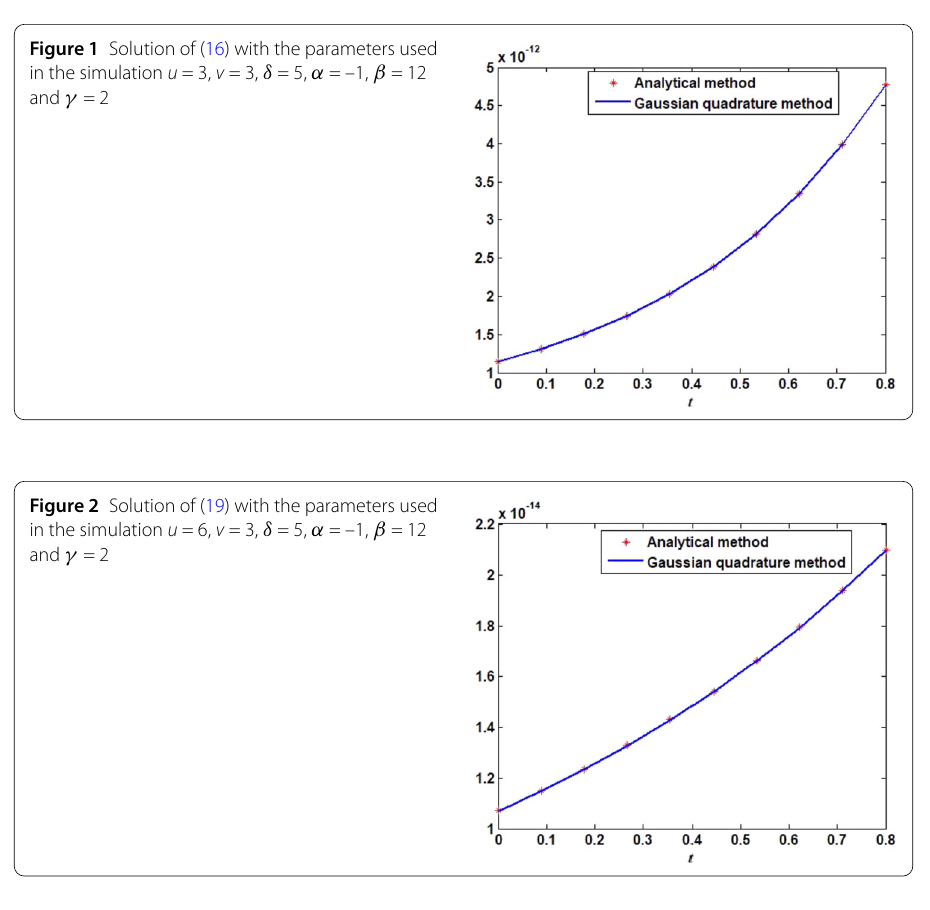
Figure 1 Solution of (16) with the parameters used in the simulation u = 3, v = 3, δ = 5, α = –1, β = 12 and γ = 2